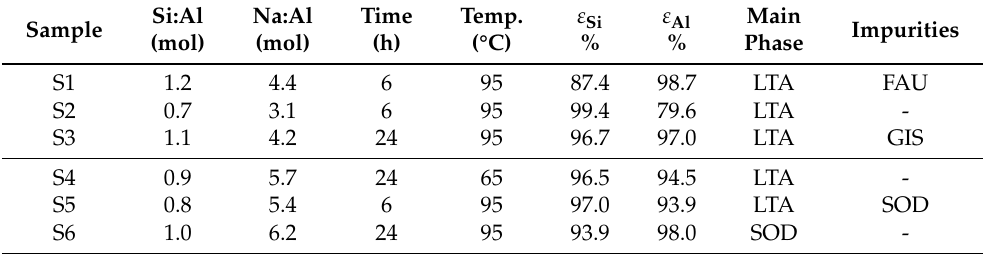
Table 4. Experimental conditions used for the hydrothermal synthesis of LTA-zeolites (step 2). The SAR was adjusted to ∼ 1.0 by the addition of solid NaAlO 2 . ε Si and ε Al indicate the removal efficiency of Si and Al from solution after the synthesis step. The mineralogical composition of the solids (product S) is indicated on the right, documenting LTA to be the dominating zeolite.